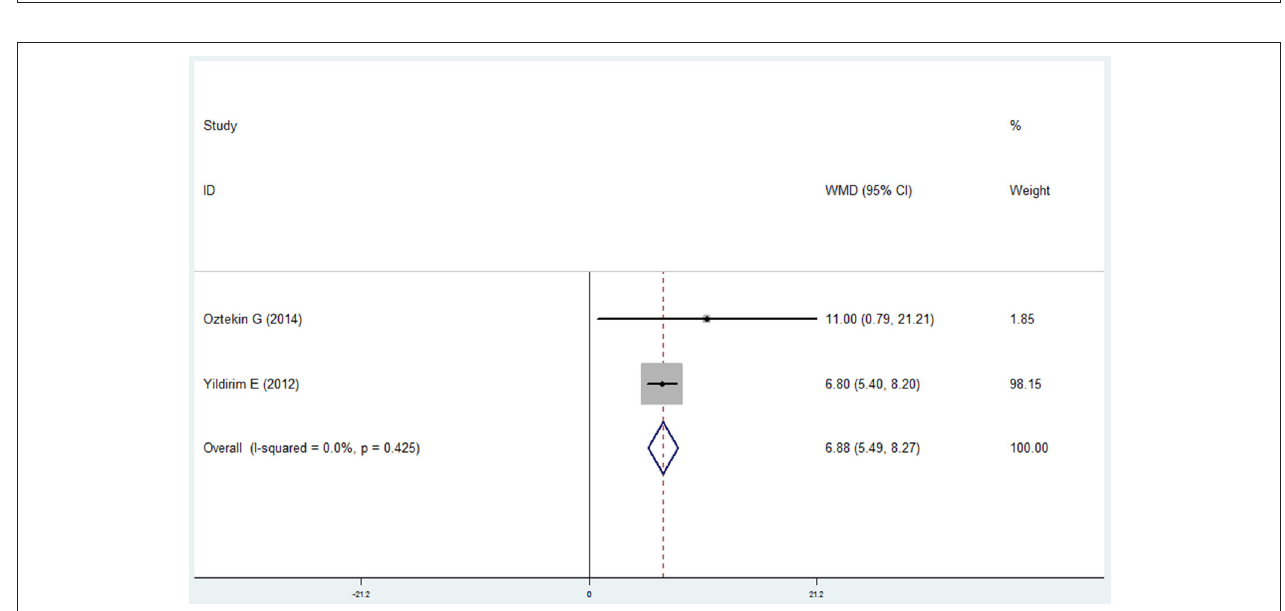
FIGURE 7 | Forest plot of the mean difference in bleeding index between the COPD and non-COPD groups.